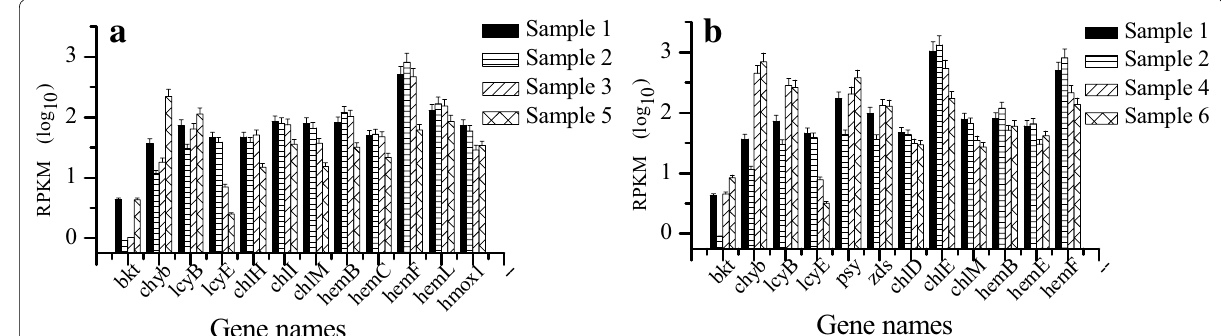
Fig. 2 The trends of RPKM in carotenoid and chlorophyll metabolism pathways: a 1235 SHDP route; b 1246 SHDP route. The number of replications is two ( n 2) =